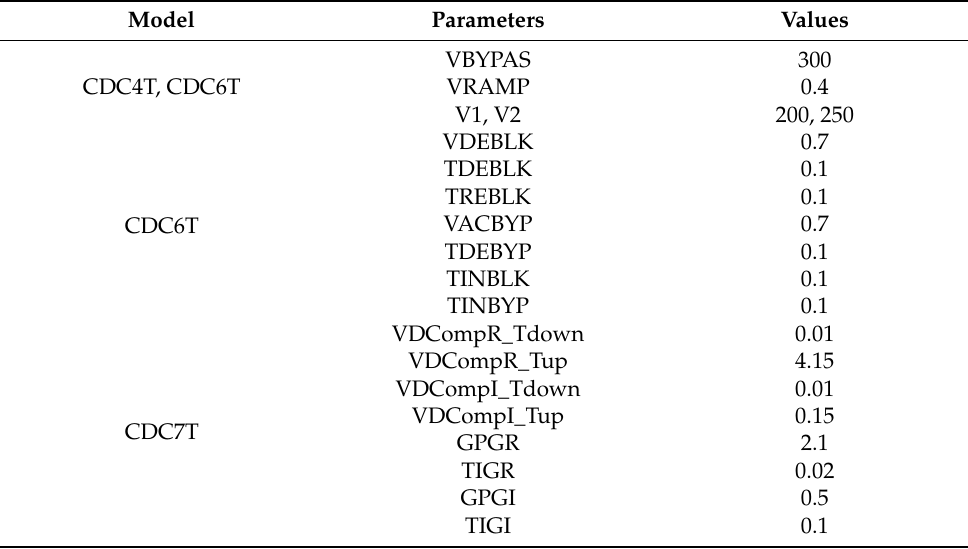
Table 6. Modified values of the generic models for the Jeju-Haenam HVDC